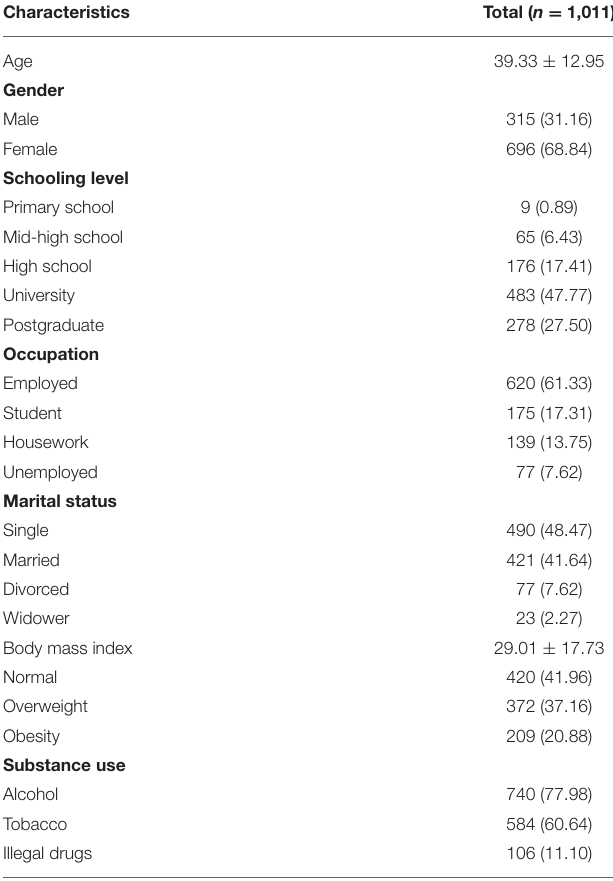
TABLE 1 | Sociodemographic characteristics of the respondents.